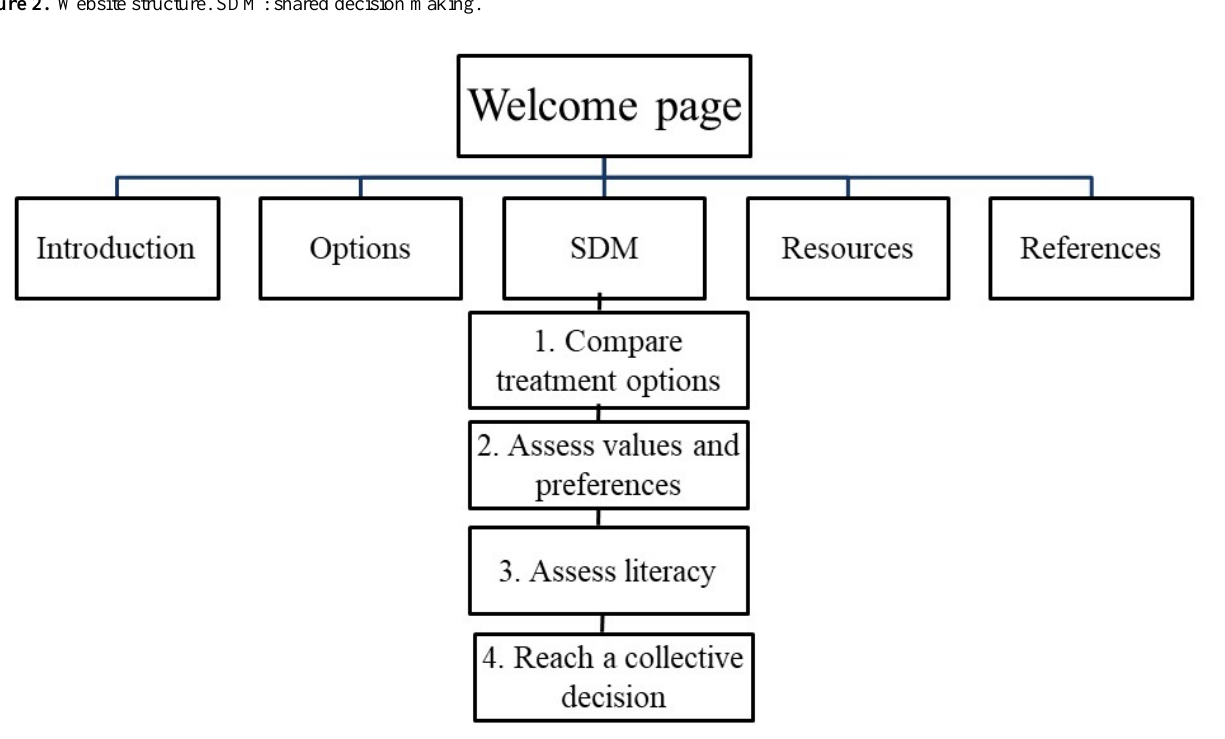
Figure 2. Website structure. SDM: shared decision